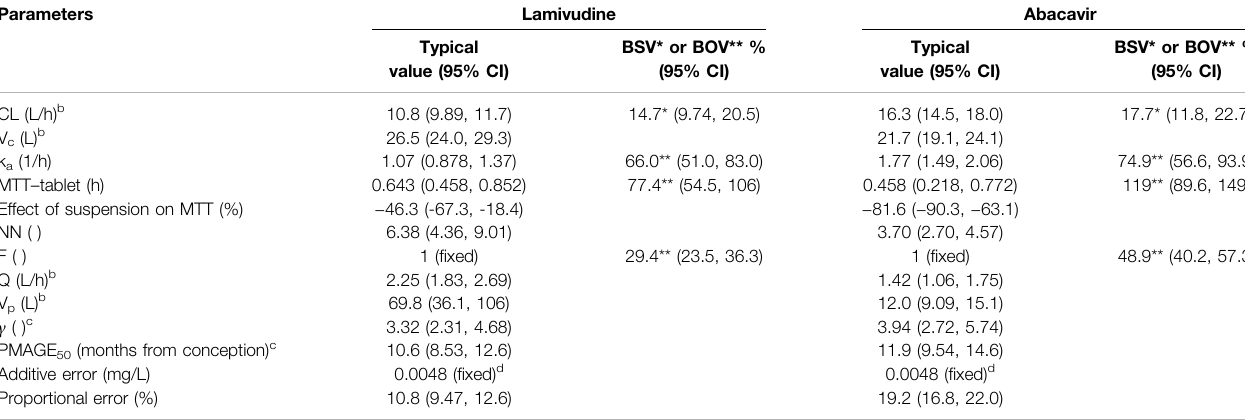
TABLE 2 | Parameter estimates of the fi nal model for lamivudine and abacavir pharmacokinetics in HIV-positive children a . Parameters